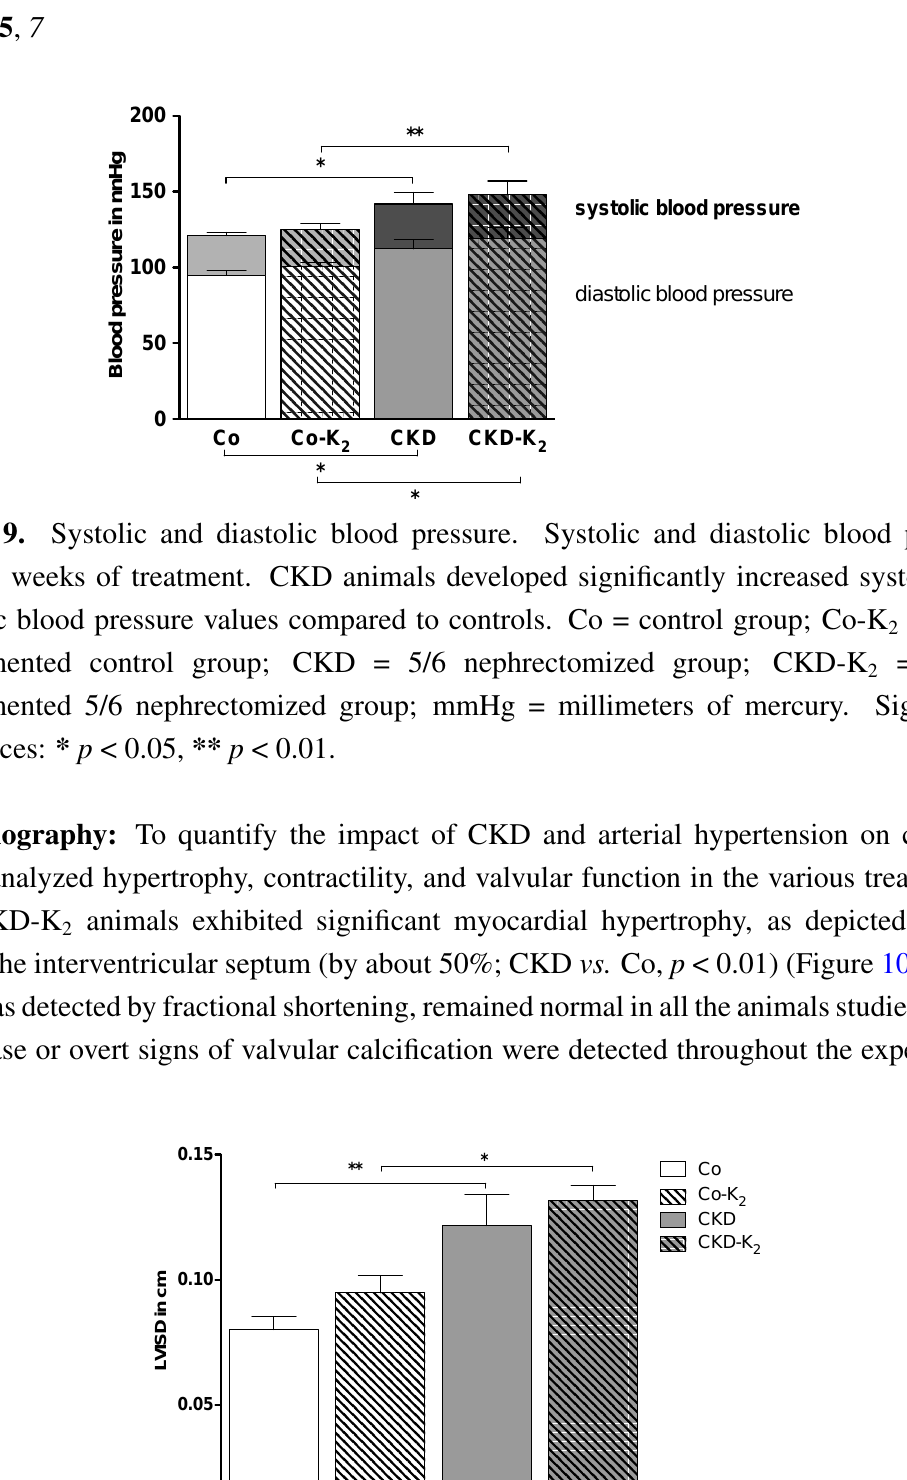
Figure 10. Echocardiography of diastolic interventricular septum diameter (LVISD) in cm. Echocardiography was performed in all animals after 12 weeks of study protocol. CKD animals developed significantly increased LVISD compared to controls. Co = control group; Co-K 2 = MK-7 supplemented control group; CKD = 5/6 nephrectomized group; CKD-K 2 = MK-7 supplemented 5/6 nephrectomized group; cm = centimeters. Significant differences: * p < 0.05, ** p < 0.01.